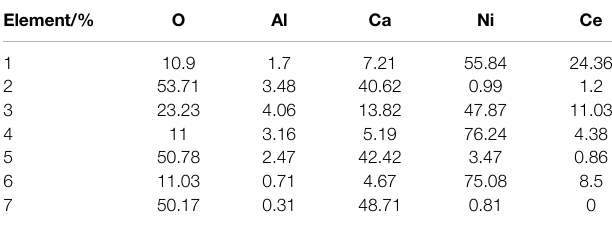
TABLE 2 | EDS table of Ce doped catalysts.